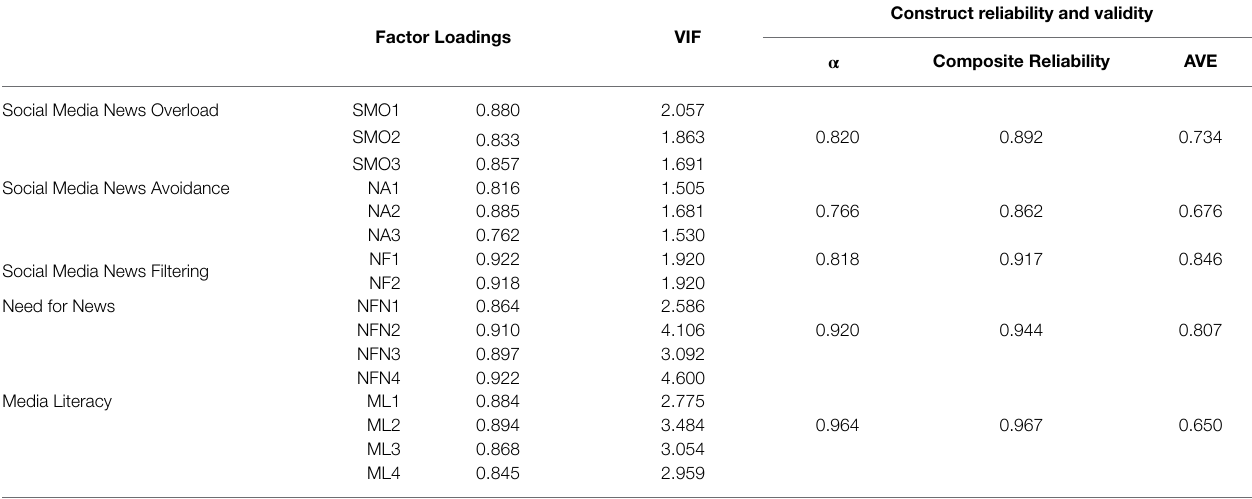
TABLE 8 | Model assessment (moderation).